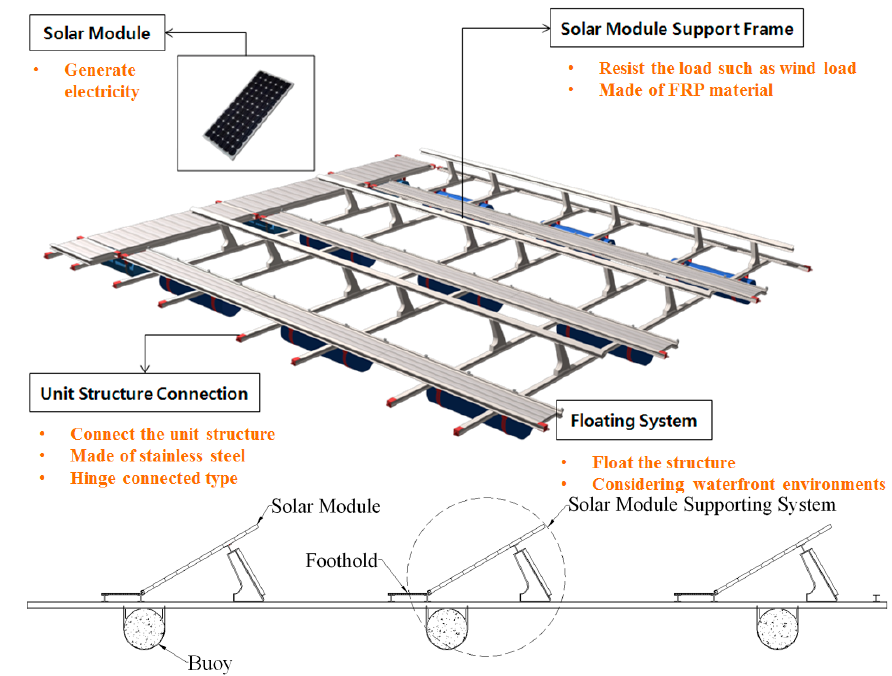
Figure 1. Composition of unit structure [6].